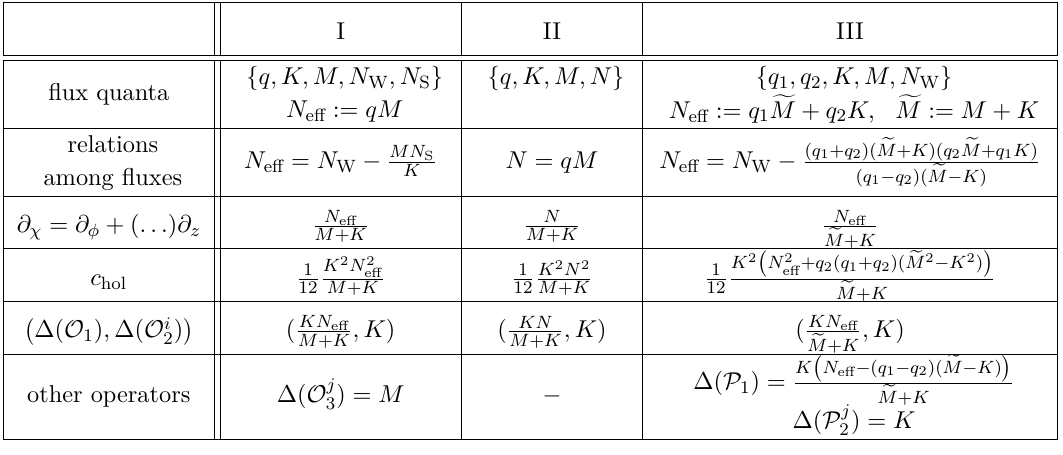
Table 1. The flux quanta, U(1) r isometry generator, holographic c -central charge, and operator dimensions of the Case I, II, III holographic SCFTs, presented in variables most amenable to comparison. Note that Case II is recovered from the limit of Case I for which N case N . In section 5, the geometries with a monopole of charge q are generalized to monopole W → N profiles corresponding to general Young